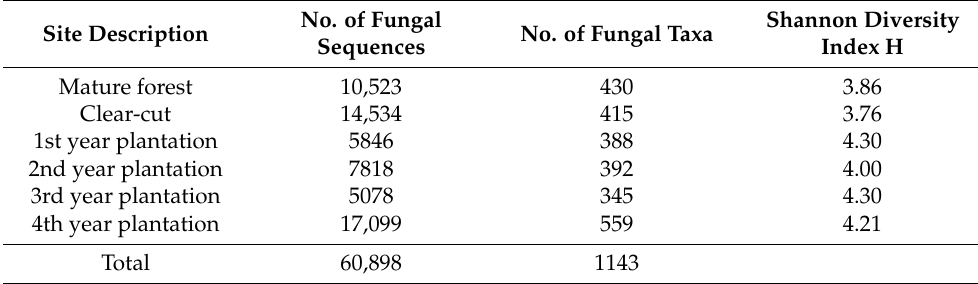
Table 3. Generated high-quality fungal sequences and detected diversity of the fungal taxa in the soil at different Pinus sylvestris L. sites in sampling sites. The data from the three study sites (A, L, and V) were